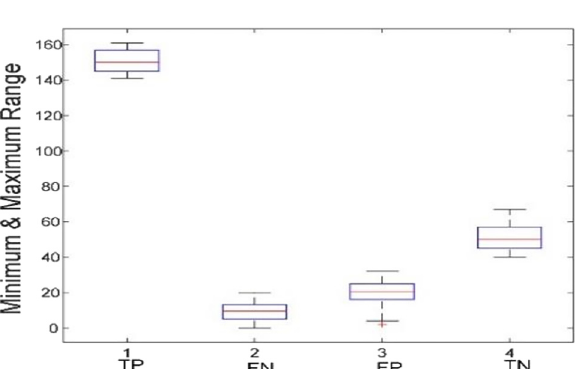
Figure 16: Boxplot (Jaya-ELM).